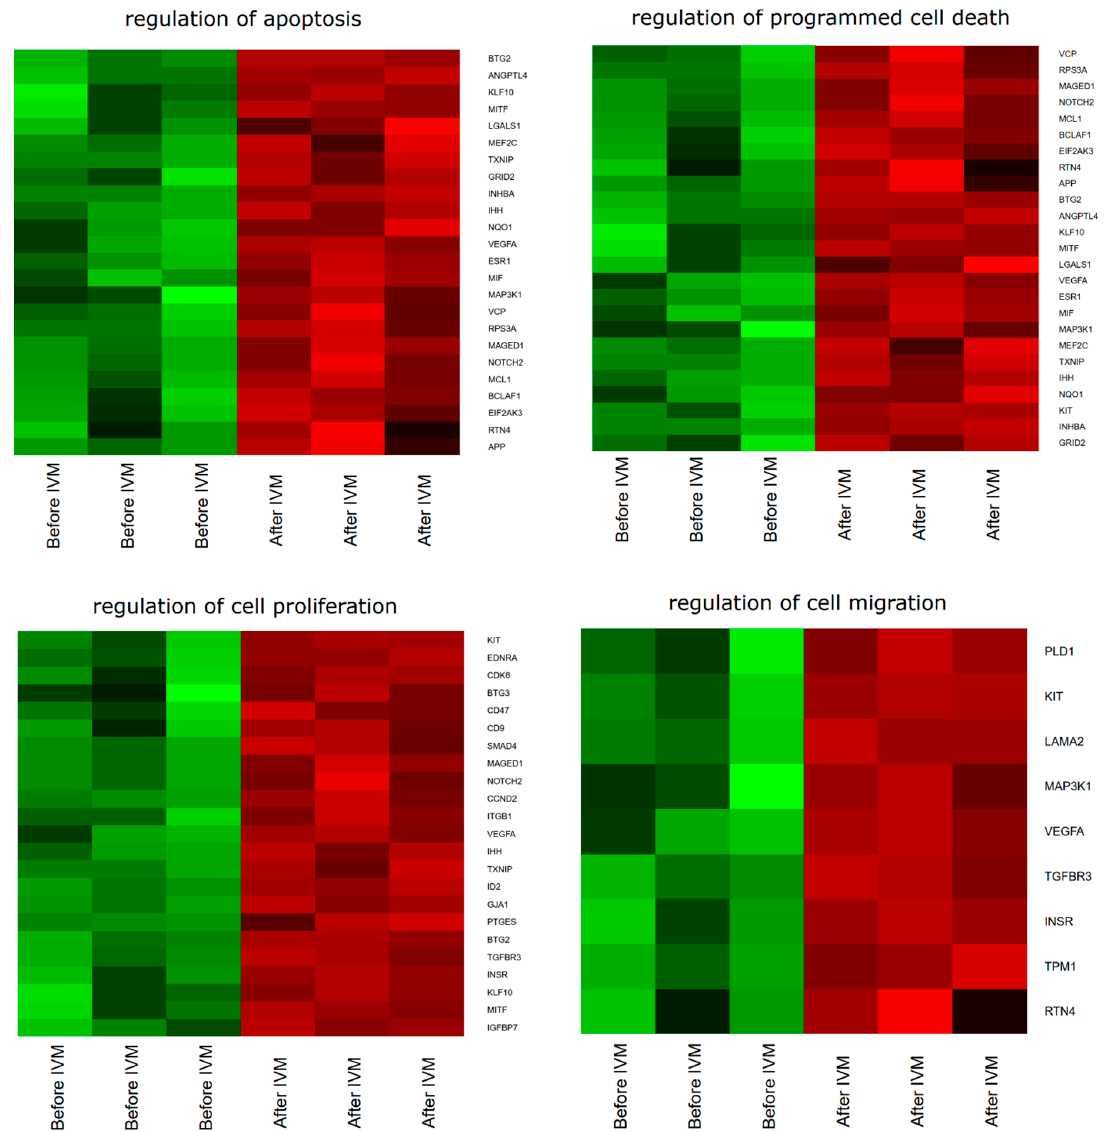
Figure 1. Heat map representations of differentially expressed genes belonging to the “cell proliferation”, “regulation of programmed cell death”, and “regulation of cell migration” GO BP (gene ontology Biological Process) terms. Arbitrary signal intensity acquired from microarray analysis is represented by colors (green, higher; red, lower expression). Log2 signal intensity values for any single gene were resized to Row Z-Score scale (from − 2, the lowest expression to +2, the highest expression for the single gene, each). Each copy of the analyzed groups represents a different biological sample.